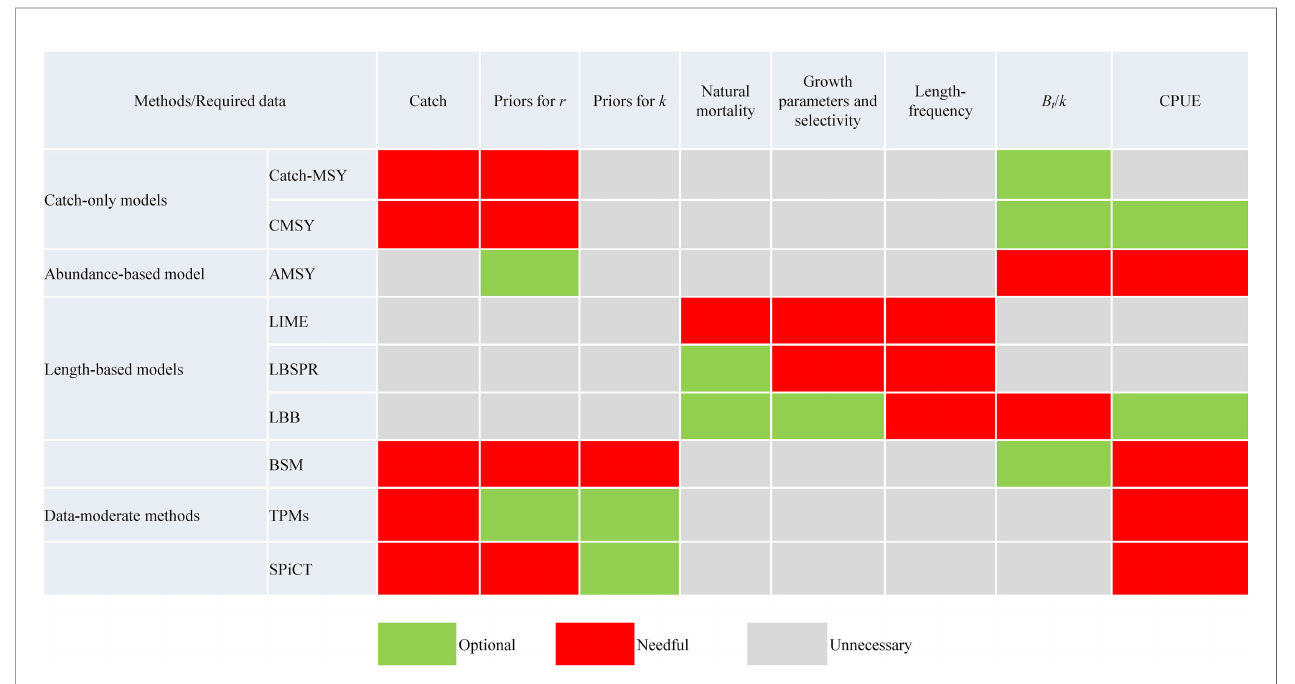
FIGURE 1 | Summary of data requirements for data-poor methods and data-moderate methods mentioned in this